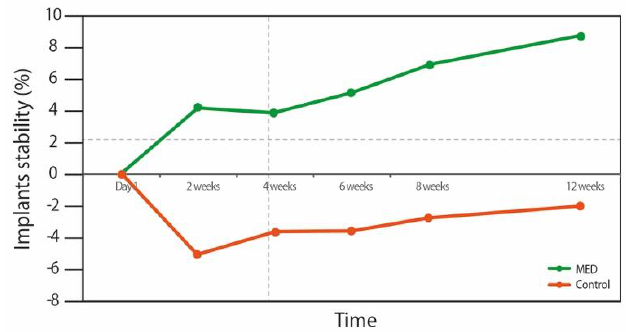
Figure 3. Intergroup repeated measures ANOVA analyses. Pairwise comparison of mean implant stability at different time points for the MED and control groups .